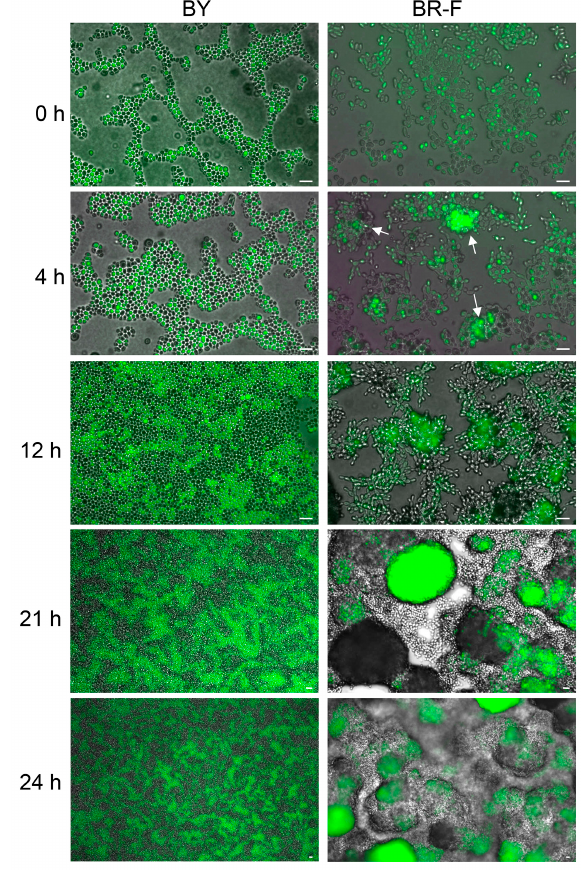
Figure 2. Timeline of cell growth in inoculated area. Agar surface was inoculated with a mixture of BY4742 (black cells) and BY-p TEF -GFP (green cell), and with a mixture of BR-F (black cells) and BR-F-p TEF -GFP (green cell), the strains were mixed equally as in Figure 1; 1 µ L drops of 10 8 cells / mL were used for inoculation. The presence of black and green cells was detected by combining GFP fluorescence imaging and bright field microscopy. Arrows indicate examples of BR-F / BR-F-p TEF -GFP cell clusters already forming 3D structures after 4 h of